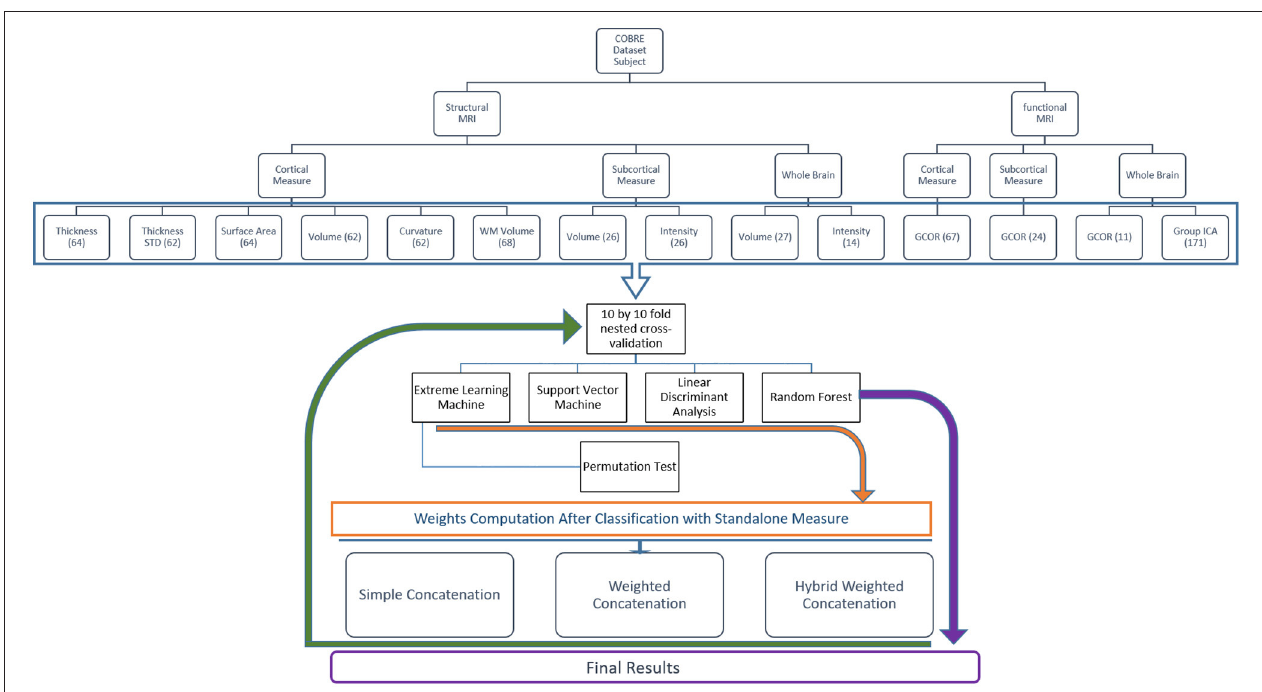
FIGURE 4 | This figure depicts the overall classification feature weighting and concatenation framework.